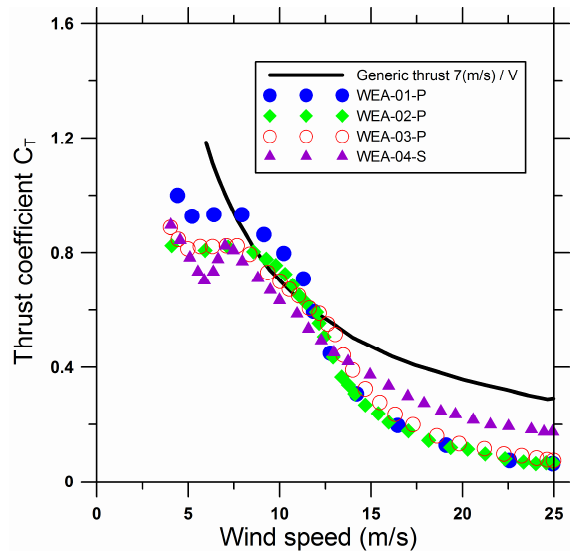
Fig. 1. The thrust coefficient, C T , as a function of wind speed, u , for a number of commercially available wind turbines (WEA-01...WEA-04) together with approximating curve given by Eq. (7). Based on data from (Frohboese and Schmuck, 2010).